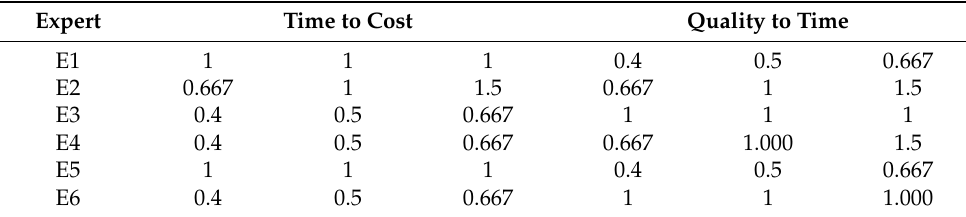
Table 3. Experts’ opinions using the SWARA